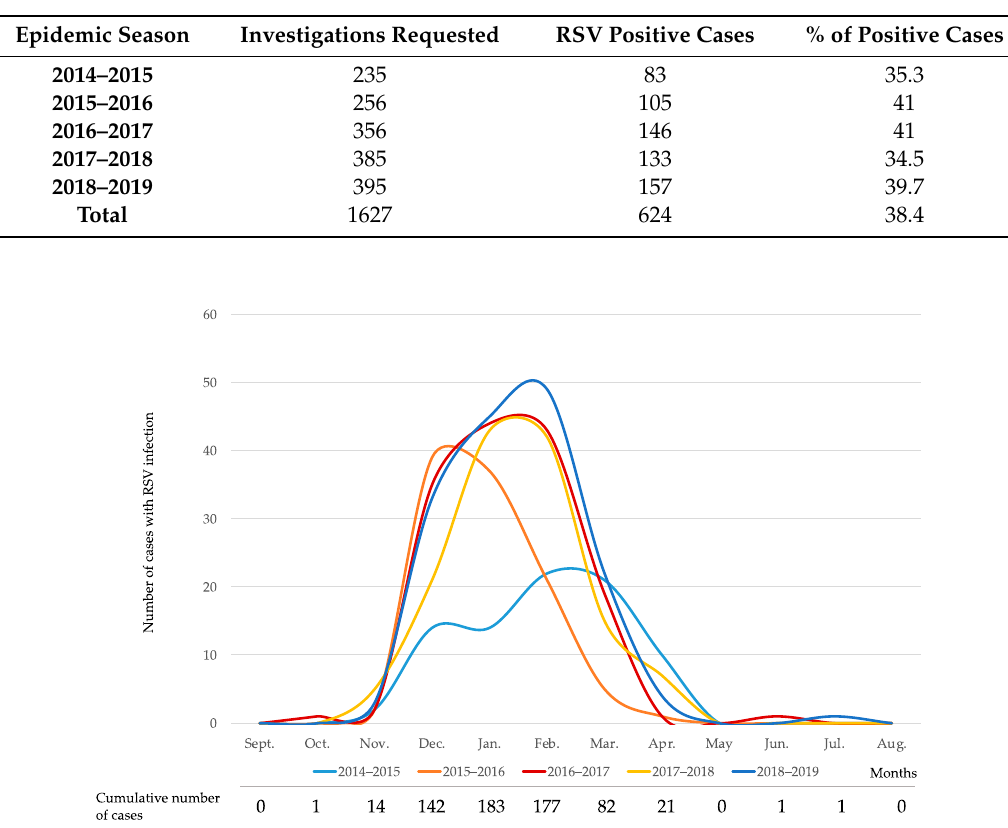
Table 2. Number of investigations requested, positive cases and % of positive cases divided by epidemic season.